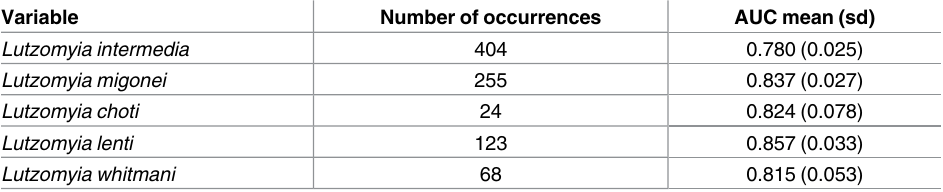
Table 1. Number of occurrence localities of phlebotomine sand fly species collected in rural loca- tions in the state of Espı´rito Santo. The mean value and standard deviation(sd) for the AUC are reported.